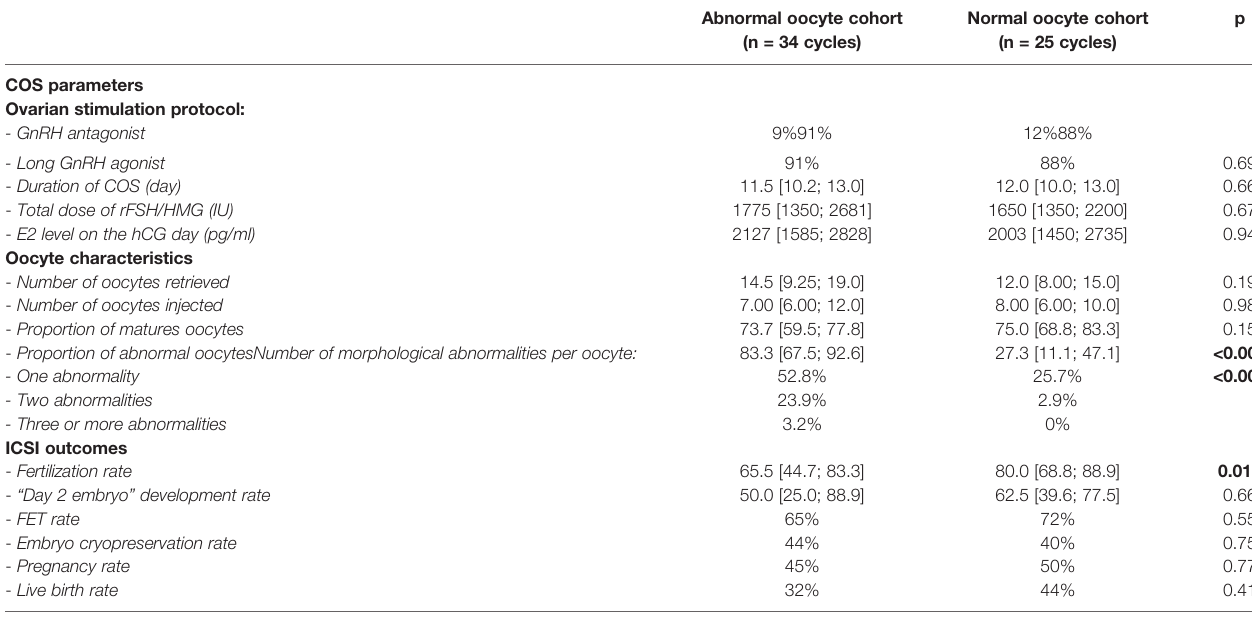
TABLE 2 | The ovarian response, oocyte characteristics, and ICSI outcomes as a function of the oocyte cohort quality.